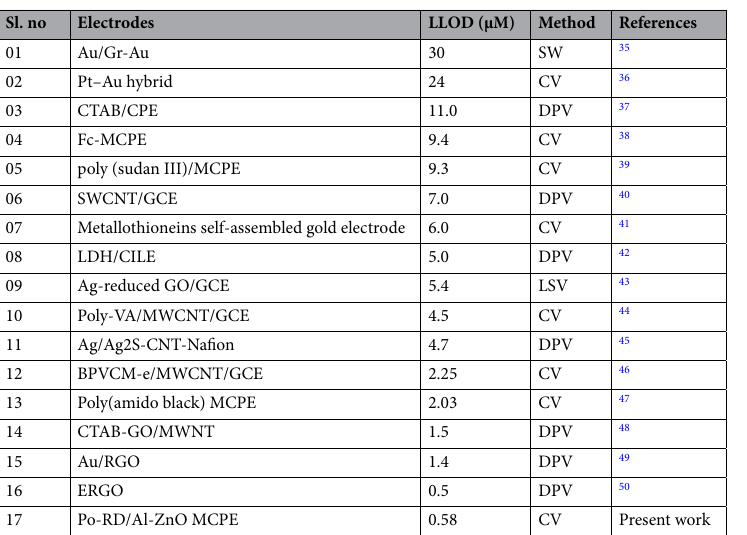
Figure 8. ( A ) CVs of DOA in 0.2 M PBS (pH 7.4) at Po-RD/Al-ZnO MCPE with various concentrations (1–6 μM). ( B ) The plot of Ipa v/s concentration OF DOA. ( C ) CVs for different pH of 5 μM DOA in 0.2 M PBS. ( D ) Plot of Epa v/s pH.